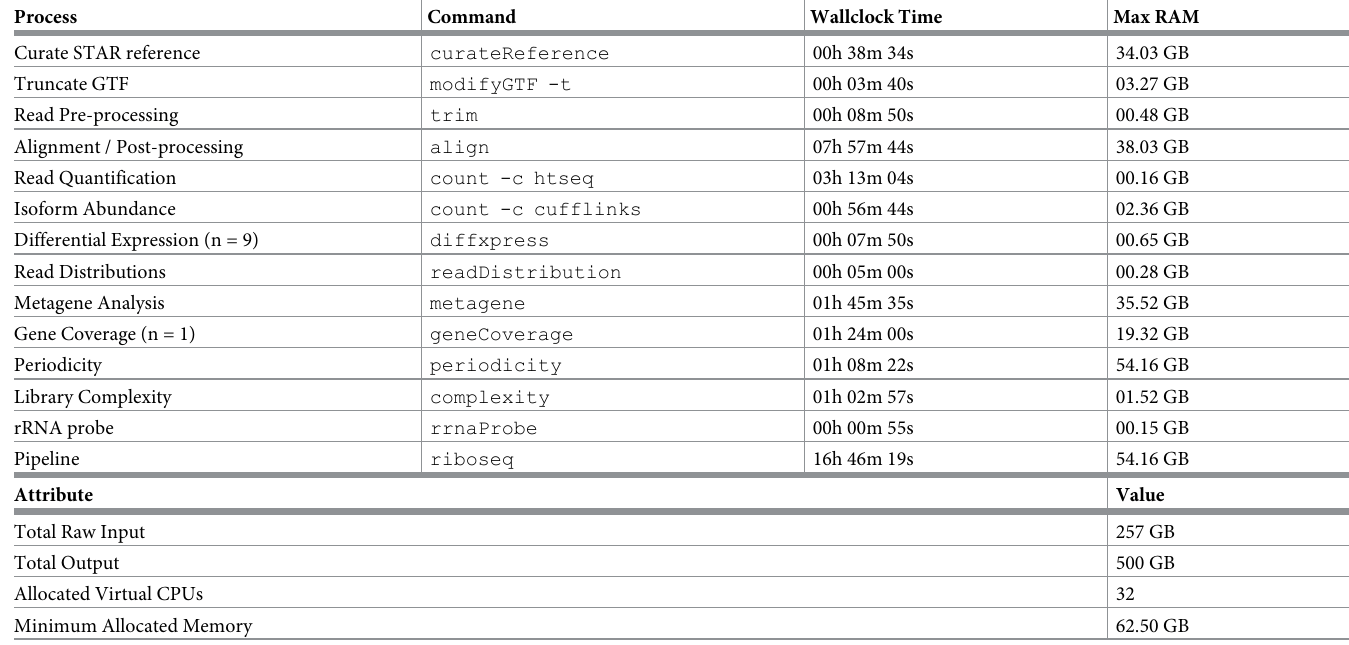
Table 2. XPRESSpipe sub-module statistics for dataset GSE65778.